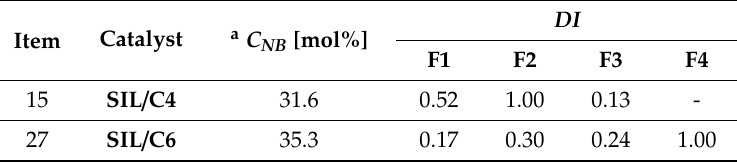
Table 3. DI values for E-NB copolymers obtained over SIL catalysts.